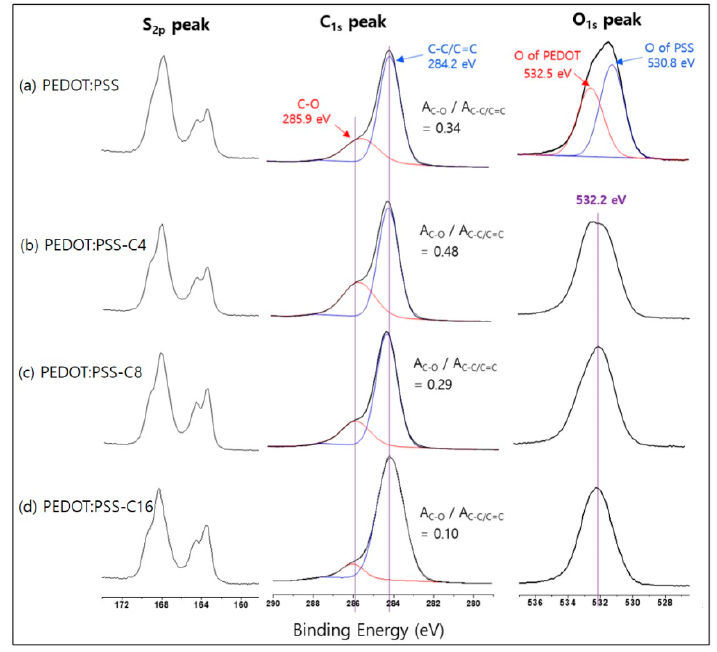
Figure 5. XPS spectra of PEDOT:PSS and derivatives.